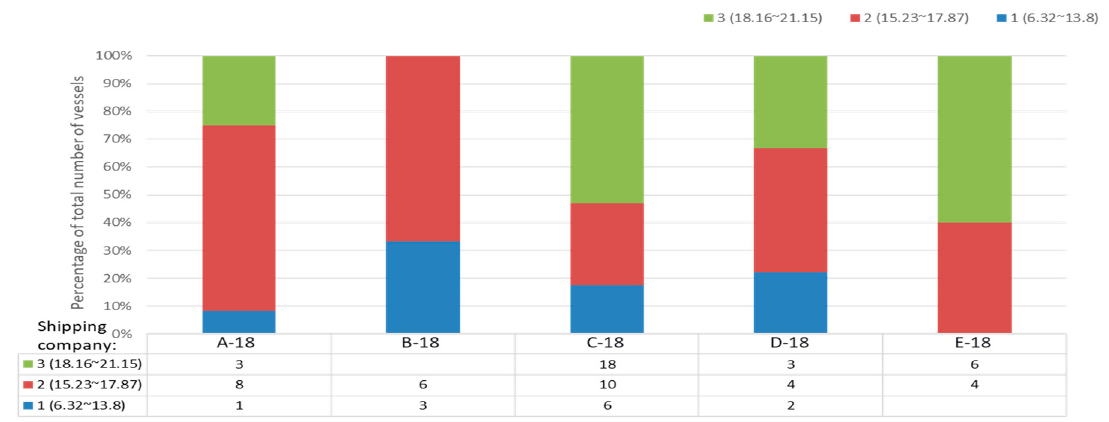
Figure 14. Speed clustering result of the 18,000 TEU container ships by shipping companies.